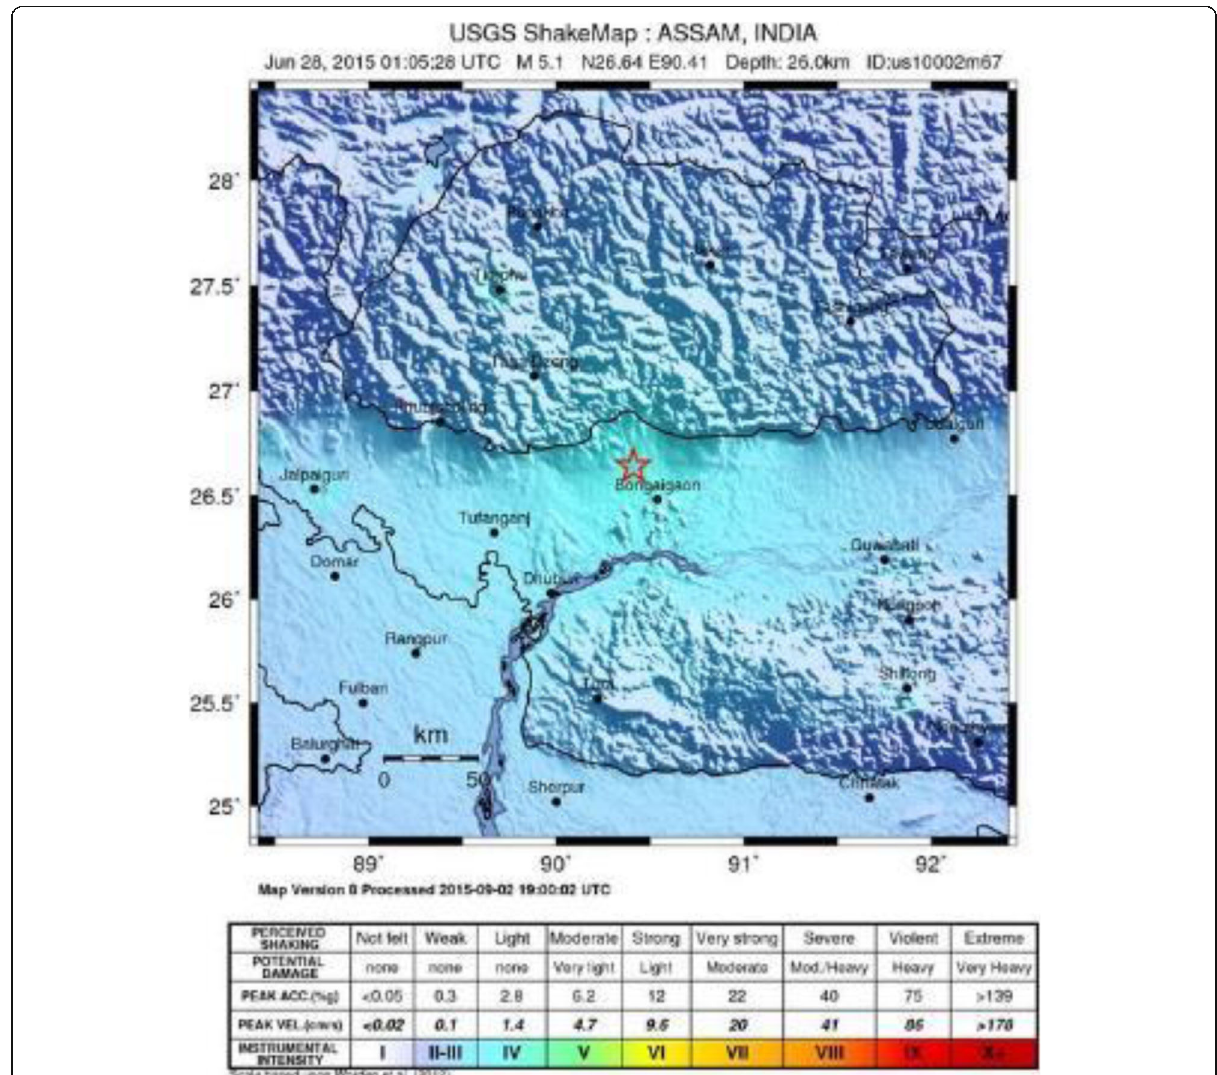
Fig. 6 Shake intensity map of M5.1 earthquake that struck Assam on the morning of 28 June 2015 (Source: